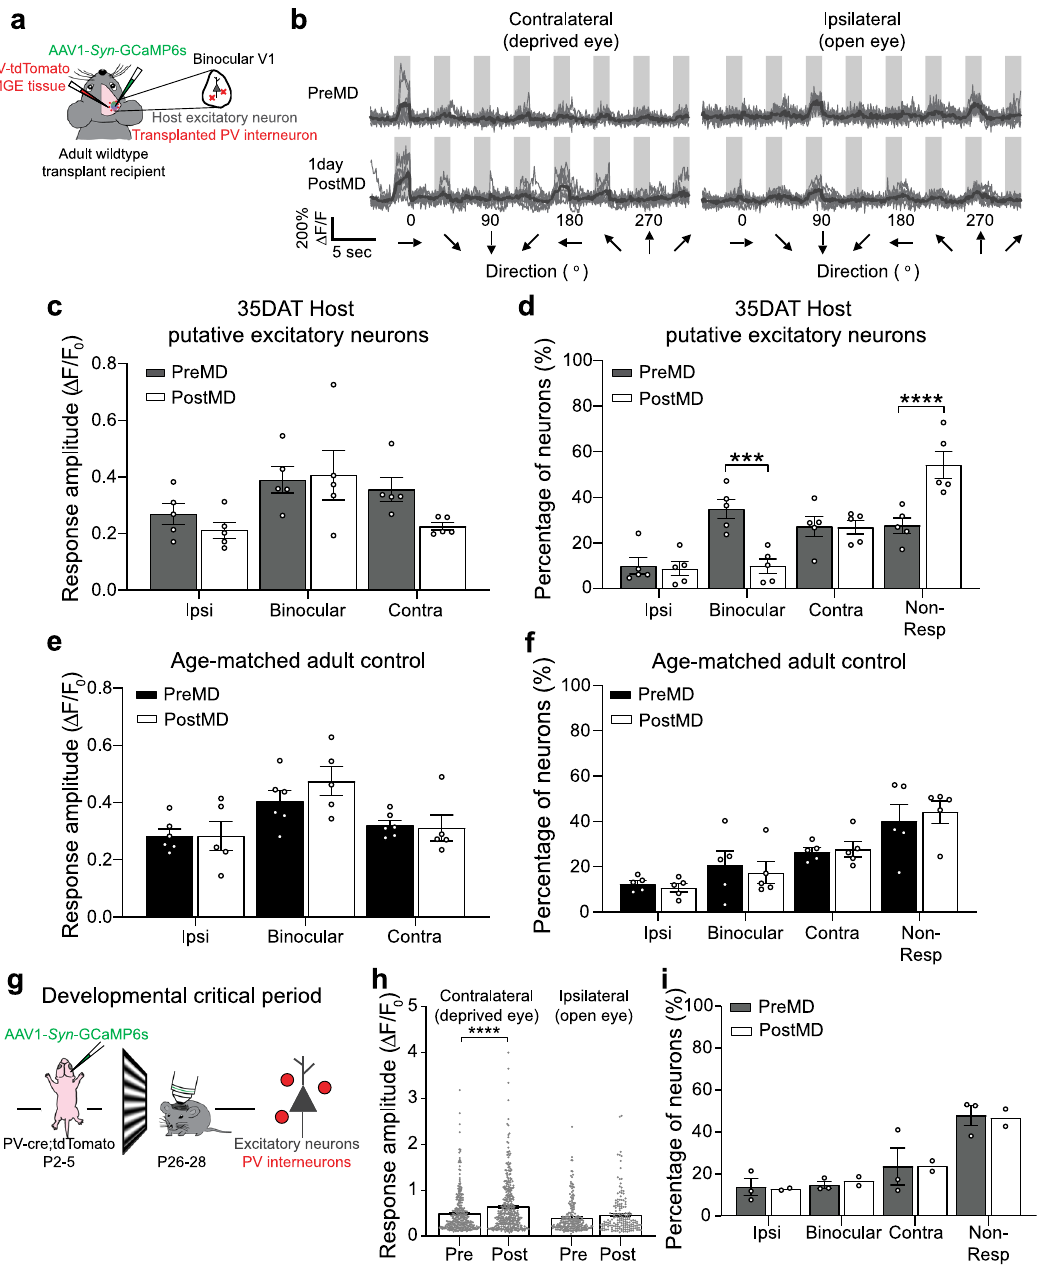
Fig. 6 Interneuron transplantation selectively reorganizes binocular responses in host cortex. a Schematic of experimental design for transplantation and viral labeling host excitatory neurons. b Visually evoked responses before and after MD of example host excitatory neurons at 35DAT. c There was no signi fi cant change in the response amplitude after MD across all three cell types ( n = 5 mice; two-way ANOVA with Bonferroni ’ s multiple comparison test). Ipsi includes neurons that only have signi fi cant ipsilateral eye responses, contra includes neurons that only have signi fi cant contralateral eye responses. Binocular includes neurons that have both ipsilateral and contralateral responses, but only the dominant eye response amplitude is plotted here. d However, percentage of binocular host excitatory neurons was reduced after 1D MD ( n = 5 mice. *** p = 0.0002; **** p = 0.00009, two-way ANOVA with Bonferroni ’ s multiple comparison test). e No change in the response amplitude of excitatory neurons in adult controls was observed (PreMD: n = 6 mice; PostMD: n = 5 mice; two-way ANOVA with Bonferroni ’ s multiple comparison test). f The percentage of responsive cells also remained unchanged after 1D MD in age-matched control mice (PreMD: n = 6 mice; PostMD: n = 5 mice, two-way ANOVA with Bonferroni ’ s multiple comparison test). g Schematic of experimental design for viral labeling excitatory neurons in neonates and Ca 2 + imaging in critical period animals. h During juvenile critical period, the response amplitude of excitatory neurons was signi fi cantly increased through the contralateral, deprived eye stimulation (contralateral: PreMD, n = 333 cells from 4 mice; PostMD, n = 373 cells from 3 mice; Ipsilateral: PreMD, n = 247 cells from 3 mice; PostMD, n = 173 cells from 2 mice. Contra: **** p = 0.00001; Ipsi: p = 0.109, Mann – Whitney U -test, two-tailed). i However, unlike in the transplant recipients, there was no change in the percentage of responsive binocular neurons after 1D MD in critical period mice. Data in c , d , e , f , h , and i are mean ± SEM. No error bars are shown for PostMD data in i since n <